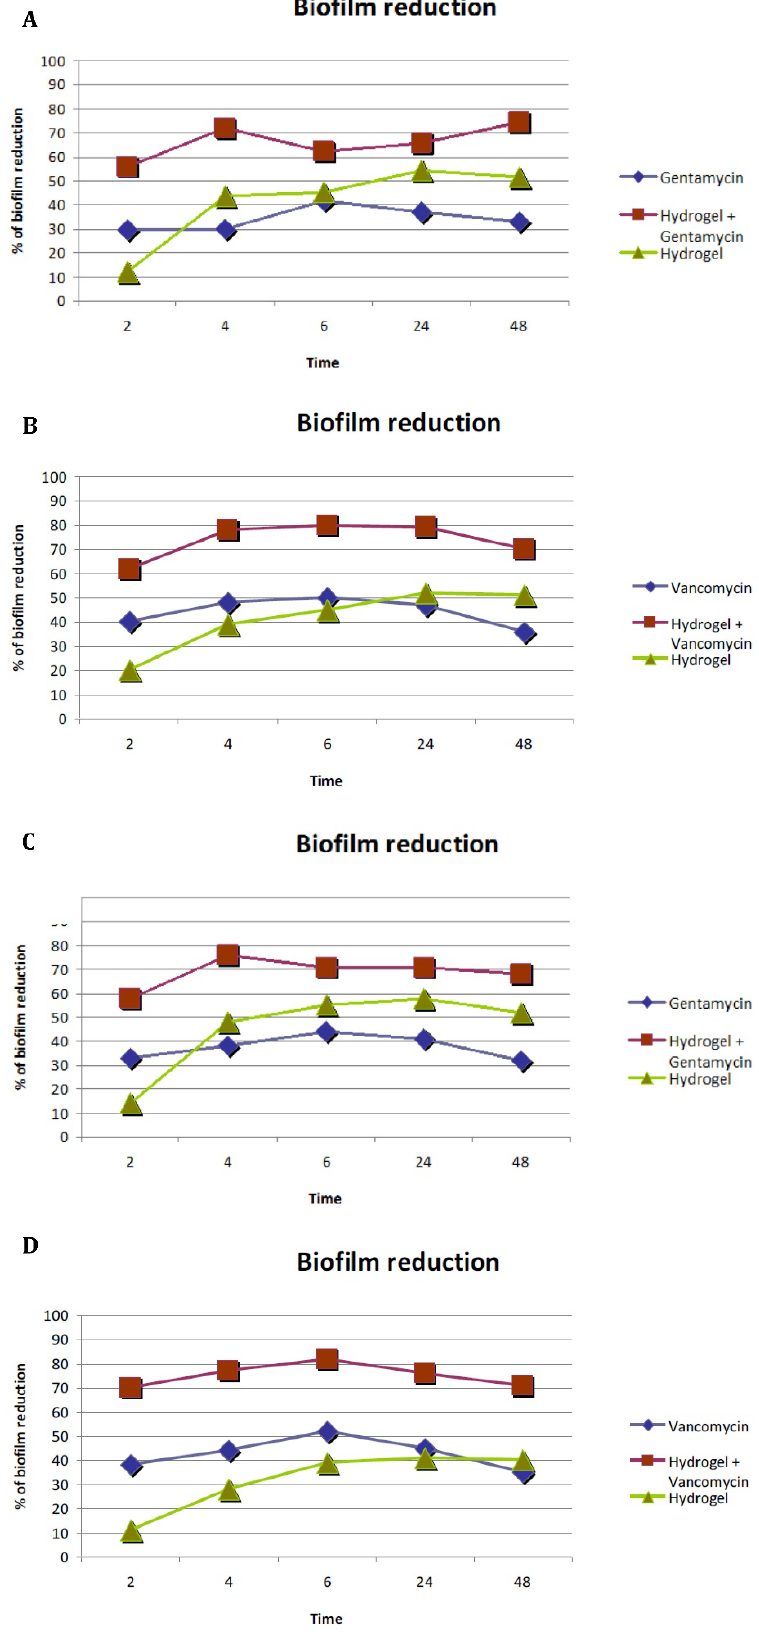
Figure 6. Comparison of the efficacy of DAC hydrogel, gentamicin, vancomycin or a combination thereof, on biofilm formation reduction of Staphylococcus aureus (A. and B.) and Staphylococcus epidermidis (C. and D.) over time (hours). Note that the hydrogel alone is able to provide an equal or superior biofilm reduction compared to commonly used antibiotics, while a synergistic effect is observed using a combination of the hyaluronic acid based hydrogel and the antibiotic